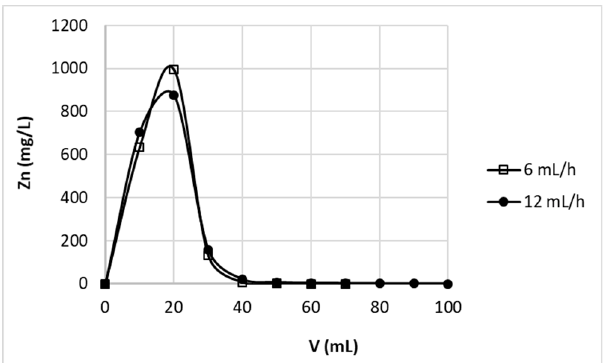
Figure 4. Effect of flow rate on zinc(II) ions stripping from hybrid pectin-based biosorbent. Mass of sorbent (dry form, fine grain): 1 g; flow rate: 6 mL/h or 12 mL/h; stripping solution: 0.1 M HNO 3 .